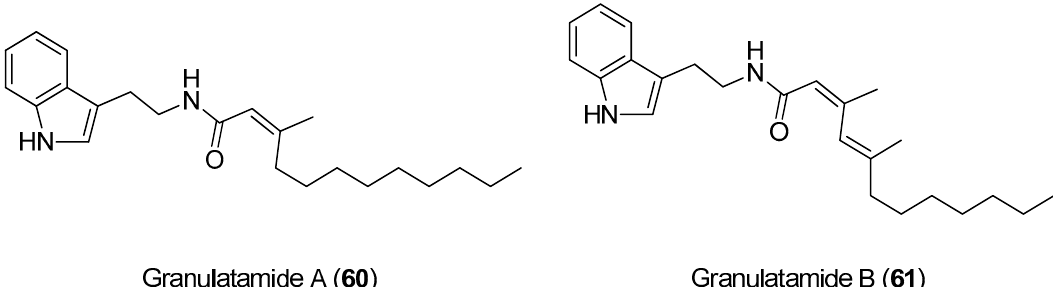
Figure 13. Structures of granulatamides A ( 60 ) and B ( 61 ) isolated from E. granulata collected in Senegal.